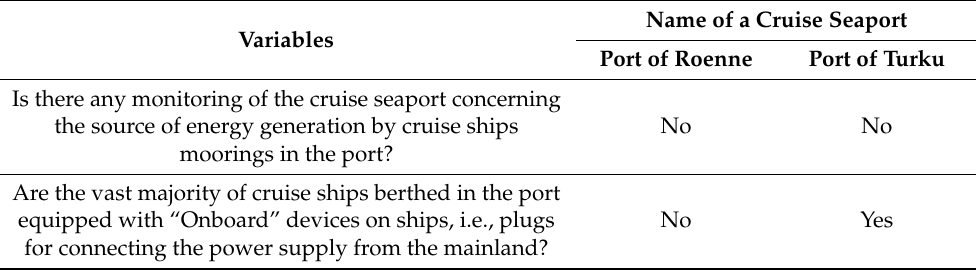
Table 7. Seaport analysis as for the sources of Onshore Power Supply for cruise